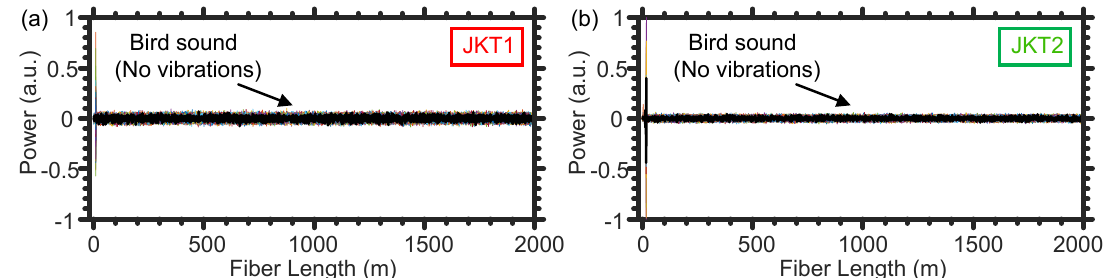
Figure 7. Representative examples of the temporal vibrations caused by the bird sounds when using the SMF of JKT1 ( a ) and JKT2 ( b